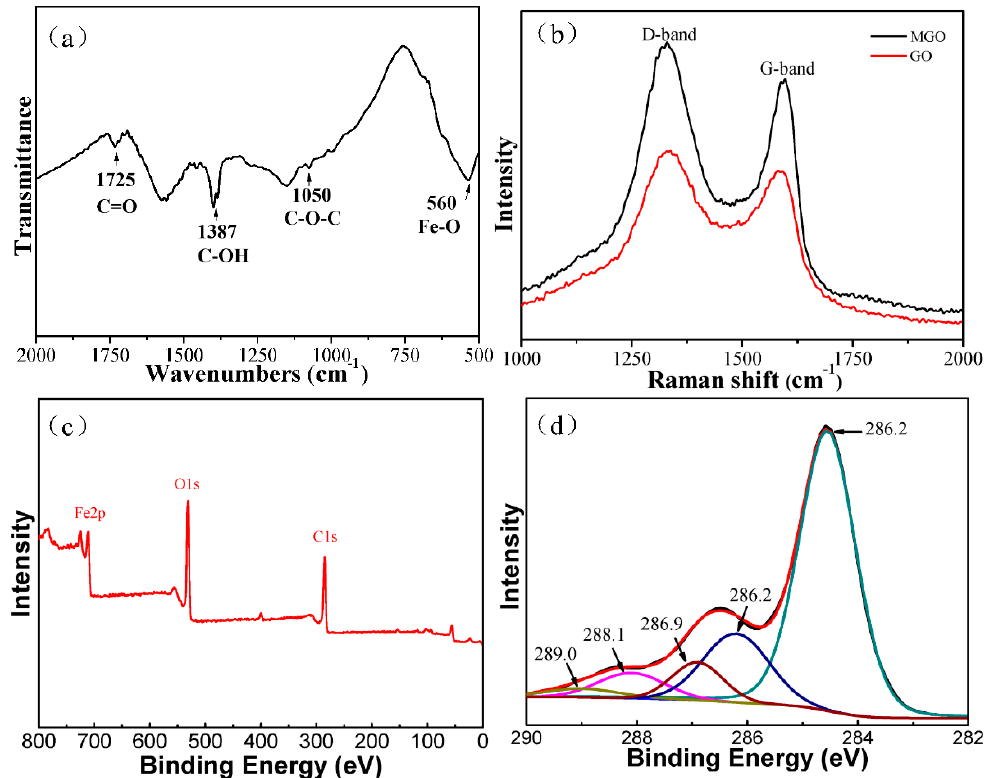
Figure 3. Characterization of MGO: ( a ) FT-IR spectrum; ( b ) Raman spectra; ( c ) XPS survey scan spectrum; ( d ) C1s XPS spectrum.